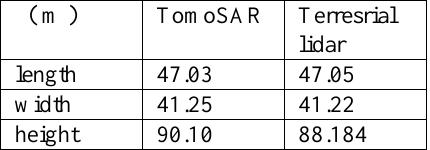
Fig4-2.Point Cloud Data Of Building Obtained From The Tomosar